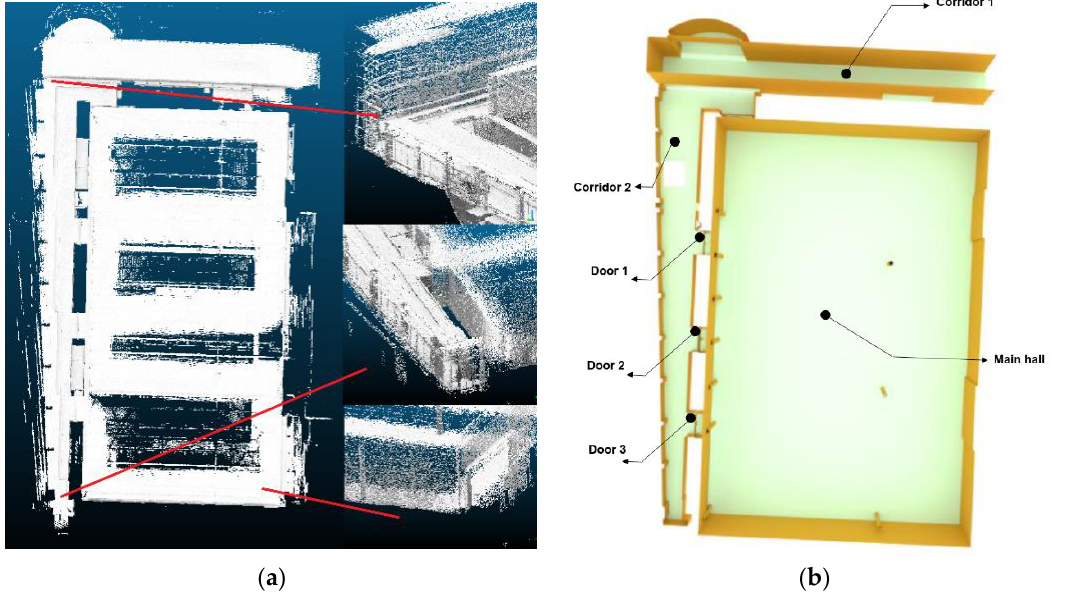
Figure 7. Quebec Convention Center building, ( a ) 3D point cloud, and ( b ) 3D vector